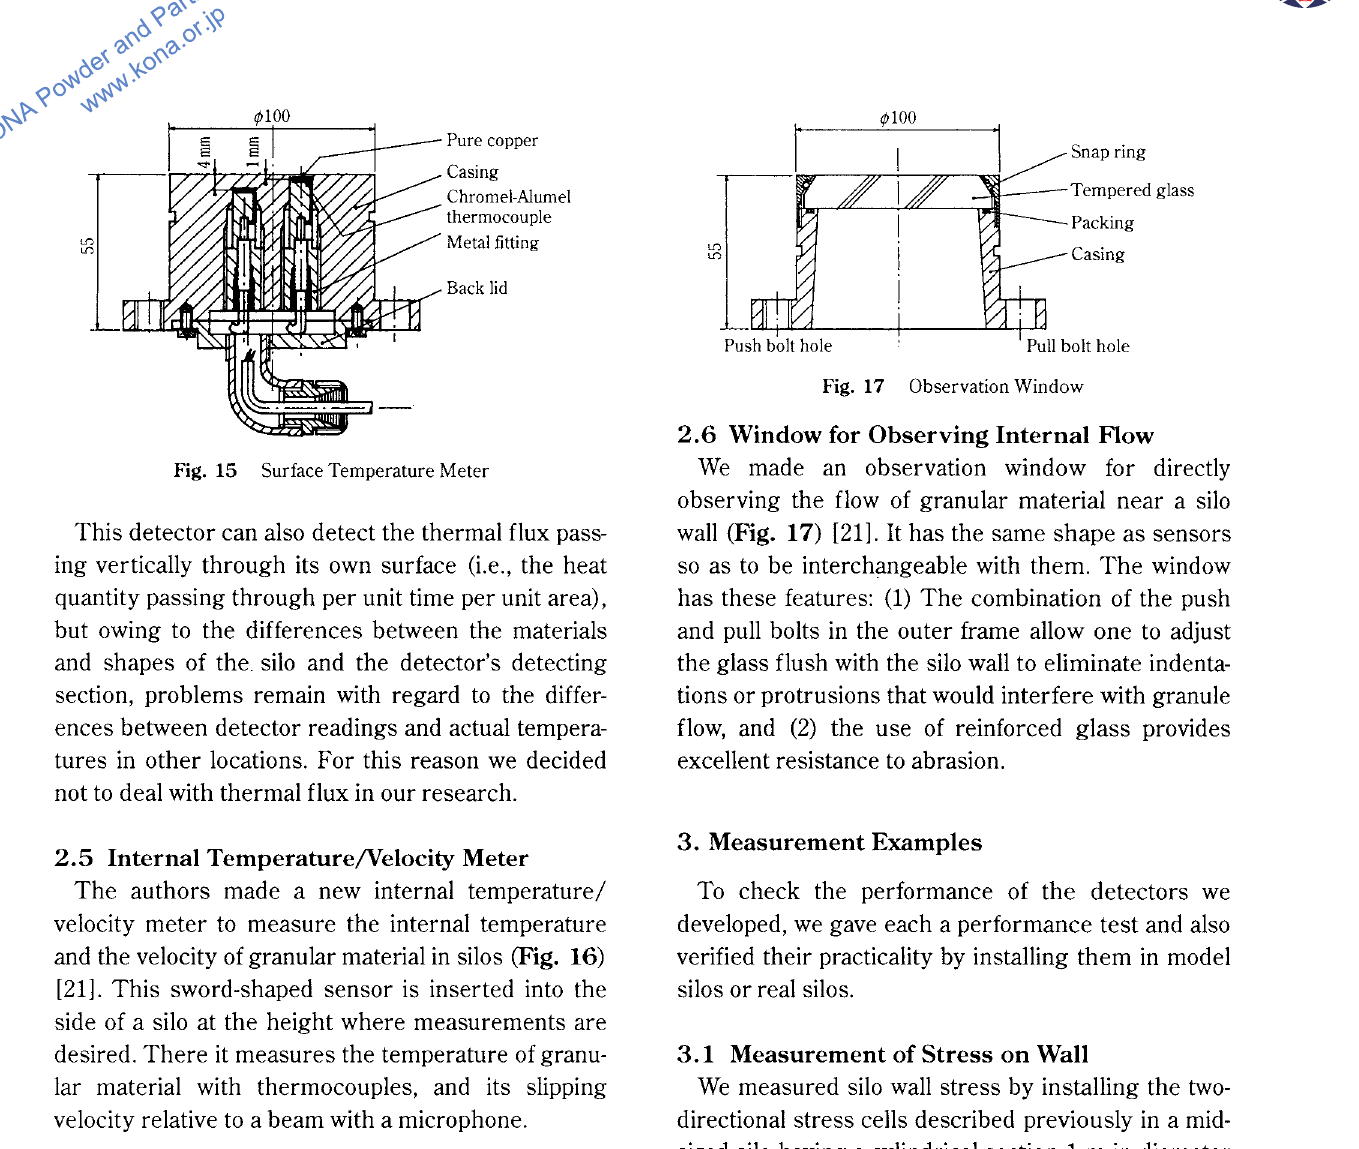
Fig. 18 Medium-size Model Silo and